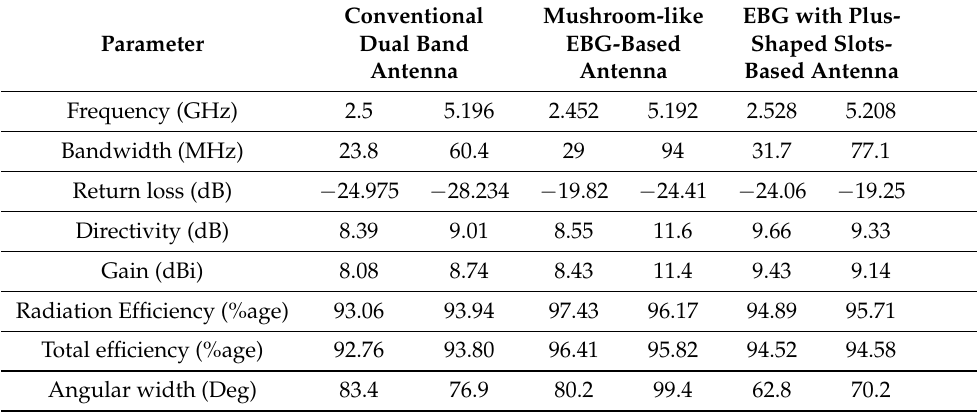
antenna without and with EBG ground planes. Table 4. Performance comparison of proposed dual band antennas with and without EBG ground